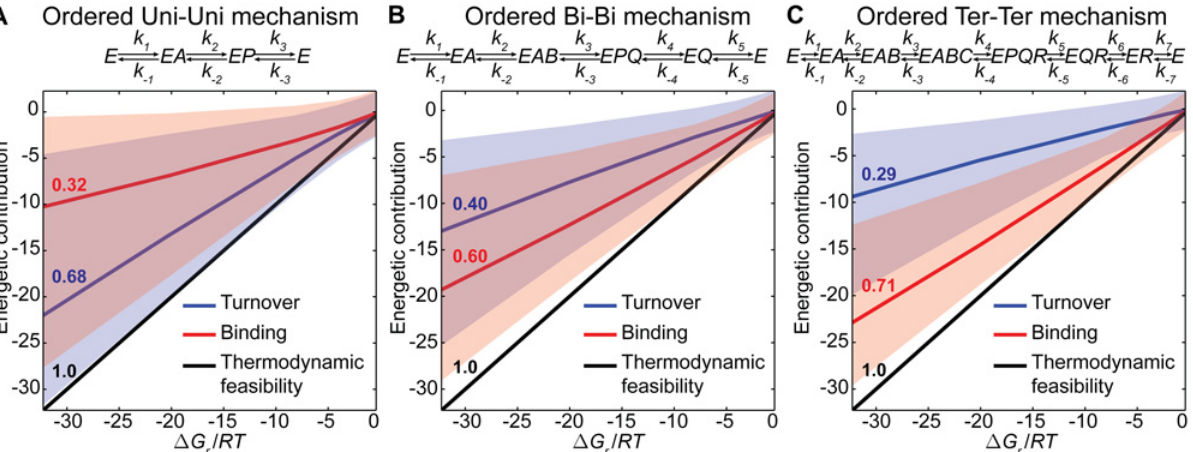
Fig 2. Energetic landscape of the contributions of the catalytic and binding terms for ordered reaction mechanisms with different molecularities. Molecularities analysed include (A) Uni-Uni, (B) Bi-Bi and (C) Ter-Ter reaction mechanisms. In each case, the following Gibbs free energy differences were considered: -1, -5, -10, -20, -30, -50 and -80 kJ/mol and a reference flux of 1 mM/min was assumed. For this analysis, 10 4 parameter sets were sampled. The blue and red lines denote the median of the distributions for the catalytic and binding terms of the reaction energetics, respectively, while the shaded areas represent the 95% confidence regions for the respective contributions. The black line represents the sum of the two contributions which yields Δ G r / RT . As it can be observed, both contributions decrease linearly with decreasing Δ G r / RT . In addition, the higher the molecularity the higher the relative importance of the binding term. The numbers showed above each line denote their slope and quantify the extent of their energetic contributions. Notably, the sum of all contributions must be one.